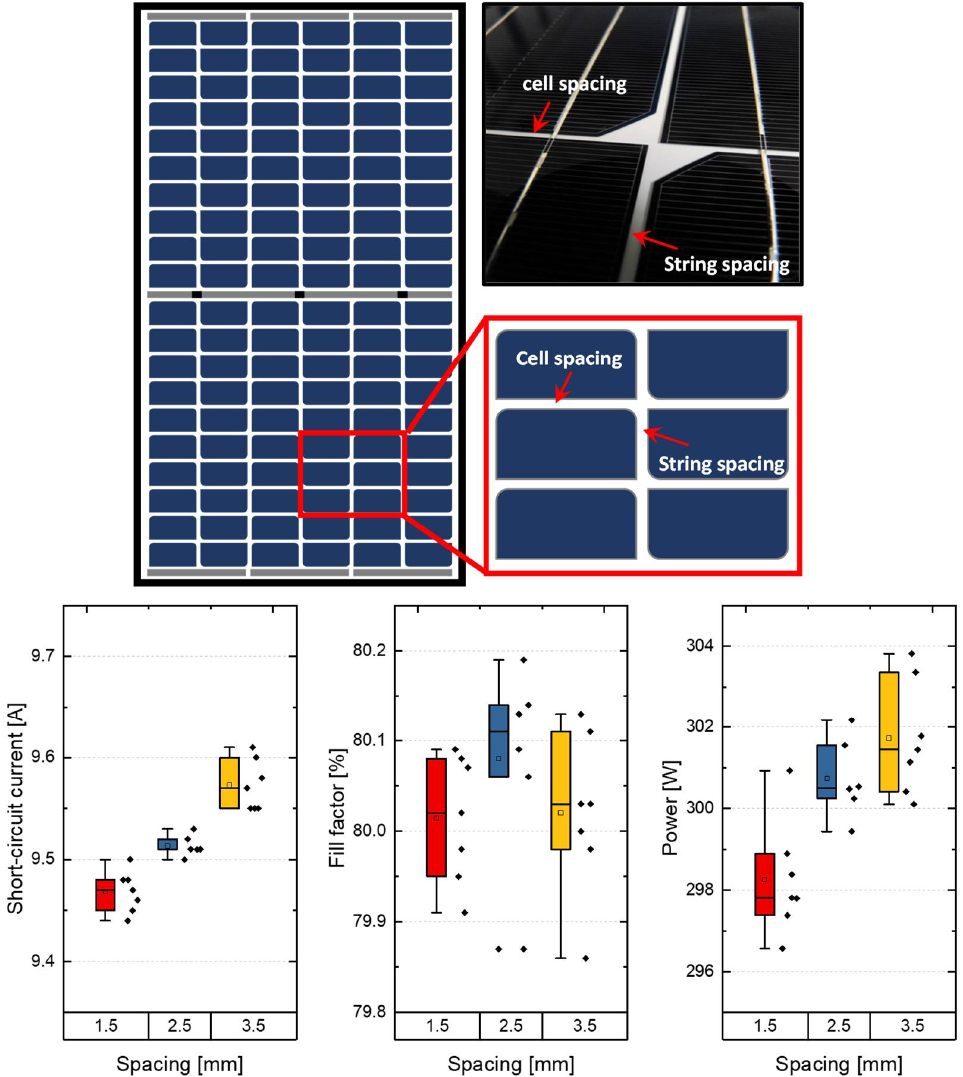
Figure 5. ( top ) Schematic and picture of the PV modules and ( bottom ) electrical characterization data of the PV modules with three different cell/string spacing groups of 1.5 mm, 2.5 mm and 3.5